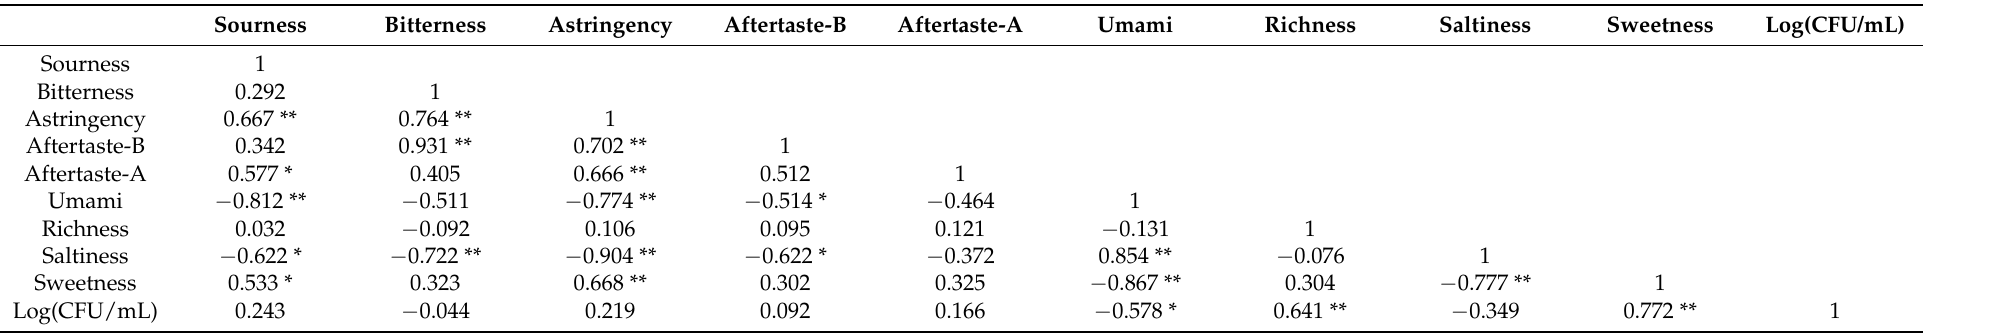
Table 6. Pearson correlation analysis between the E-tongue response values and the total bacterial count of freshly squeezed strawberry juice during cold storage. Sourness Bitterness Astringency Aftertaste-B Aftertaste-A Umami Richness Saltiness Sweetness